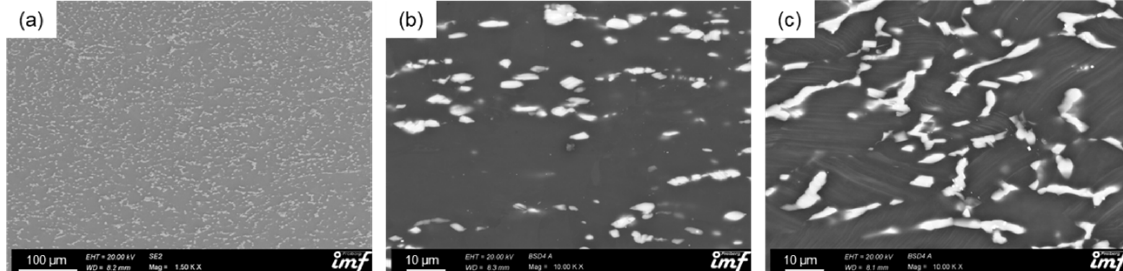
Figure 5. SEM images of the as-rolled WZ73 alloy (sample #2) produced with an equivalent strain of 0.52 and a strain rate of 27.3 s − 1 : ( a ) Overview, ( b ) detail, and ( c ) occurrence of lamellar LPSO structures within the magnesium matrix.